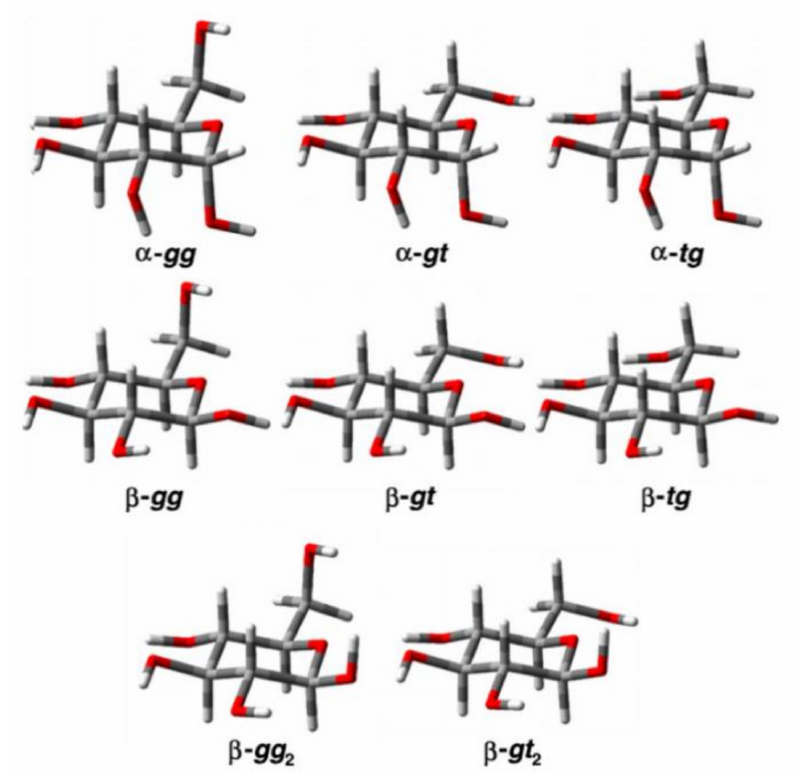
Figure 11. The conformers of α - and β -D-glucopyranose. Reproduced from Roslund et al. [111] with the permission of Elsevier.